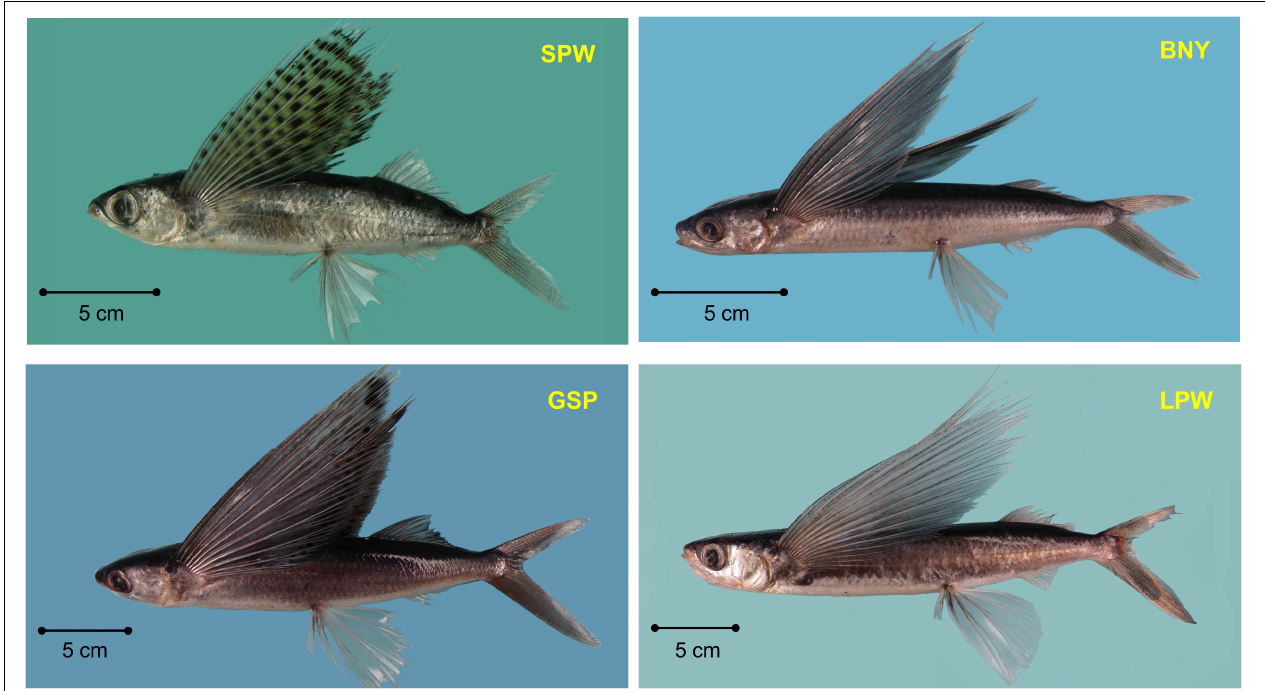
FIGURE 2 | Four important flyingfishes occurred in Taiwan. SPW, spotwing flyingfish ( Cypselurus poecilopterus ); BNY, bony flyingfish ( Hirundichthys oxycephalus ); GSP, greater spotted flyingfish ( Cheilopogon atrisignis ); LPW, limpidwing flyingfish ( Cheilopogon unicolor ).